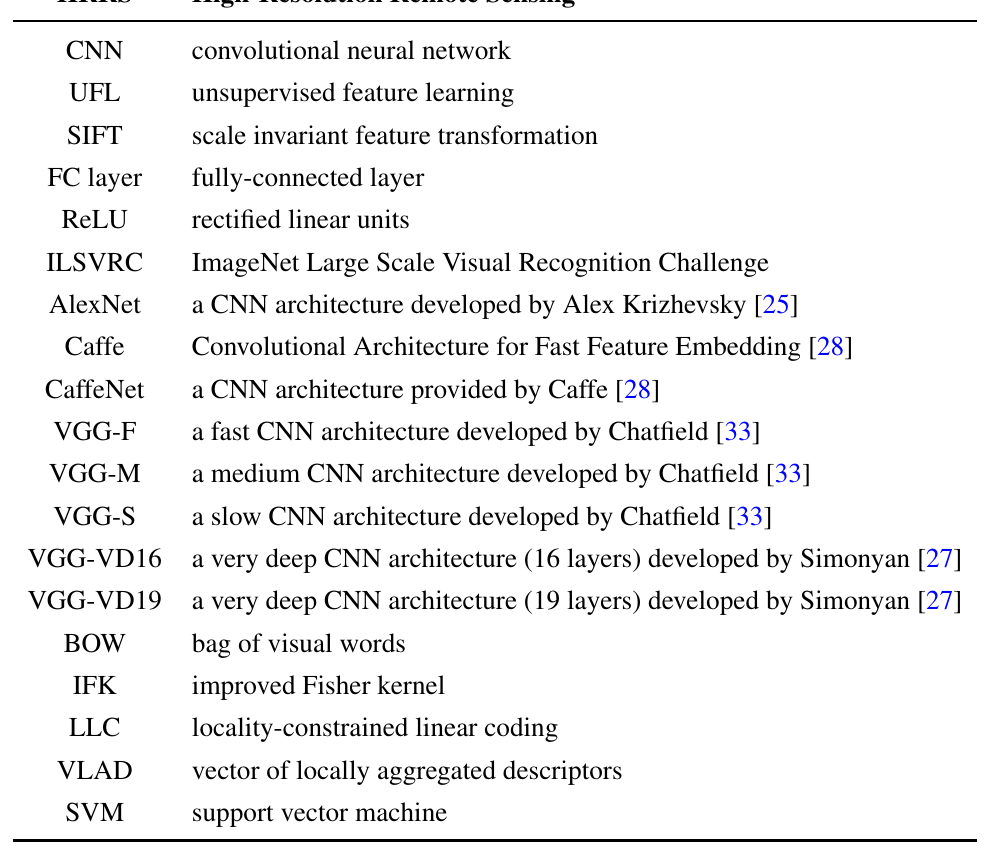
Table 1. List of Some Important Items and Corresponding